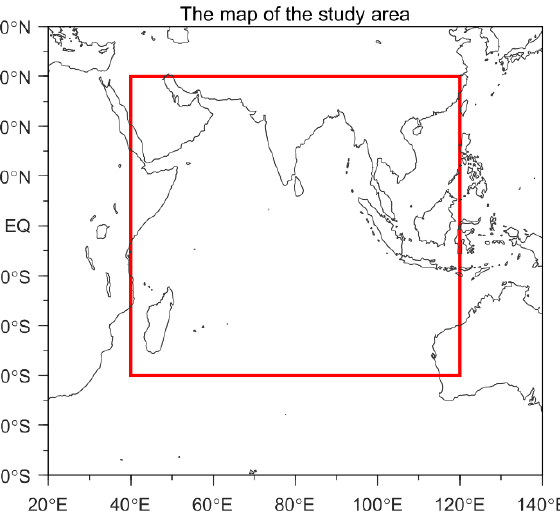
Figure 1. Map of the study area. The red rectangle indicates the tropical Indian Ocean (40°E–120°E, 30°S–30°N).